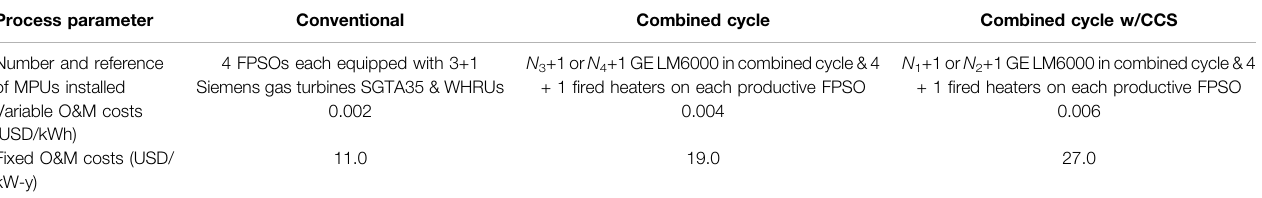
TABLE 1 | Variable and fi xed operation and maintenance (O&M) costs as a function of the power technology considered in the conventional and power hub-based utility systems.